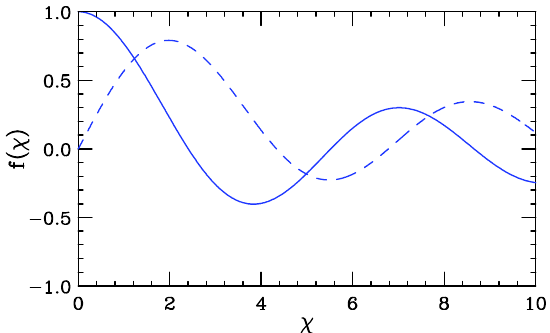
by the blue solid and the blue dashed lines, respectively.